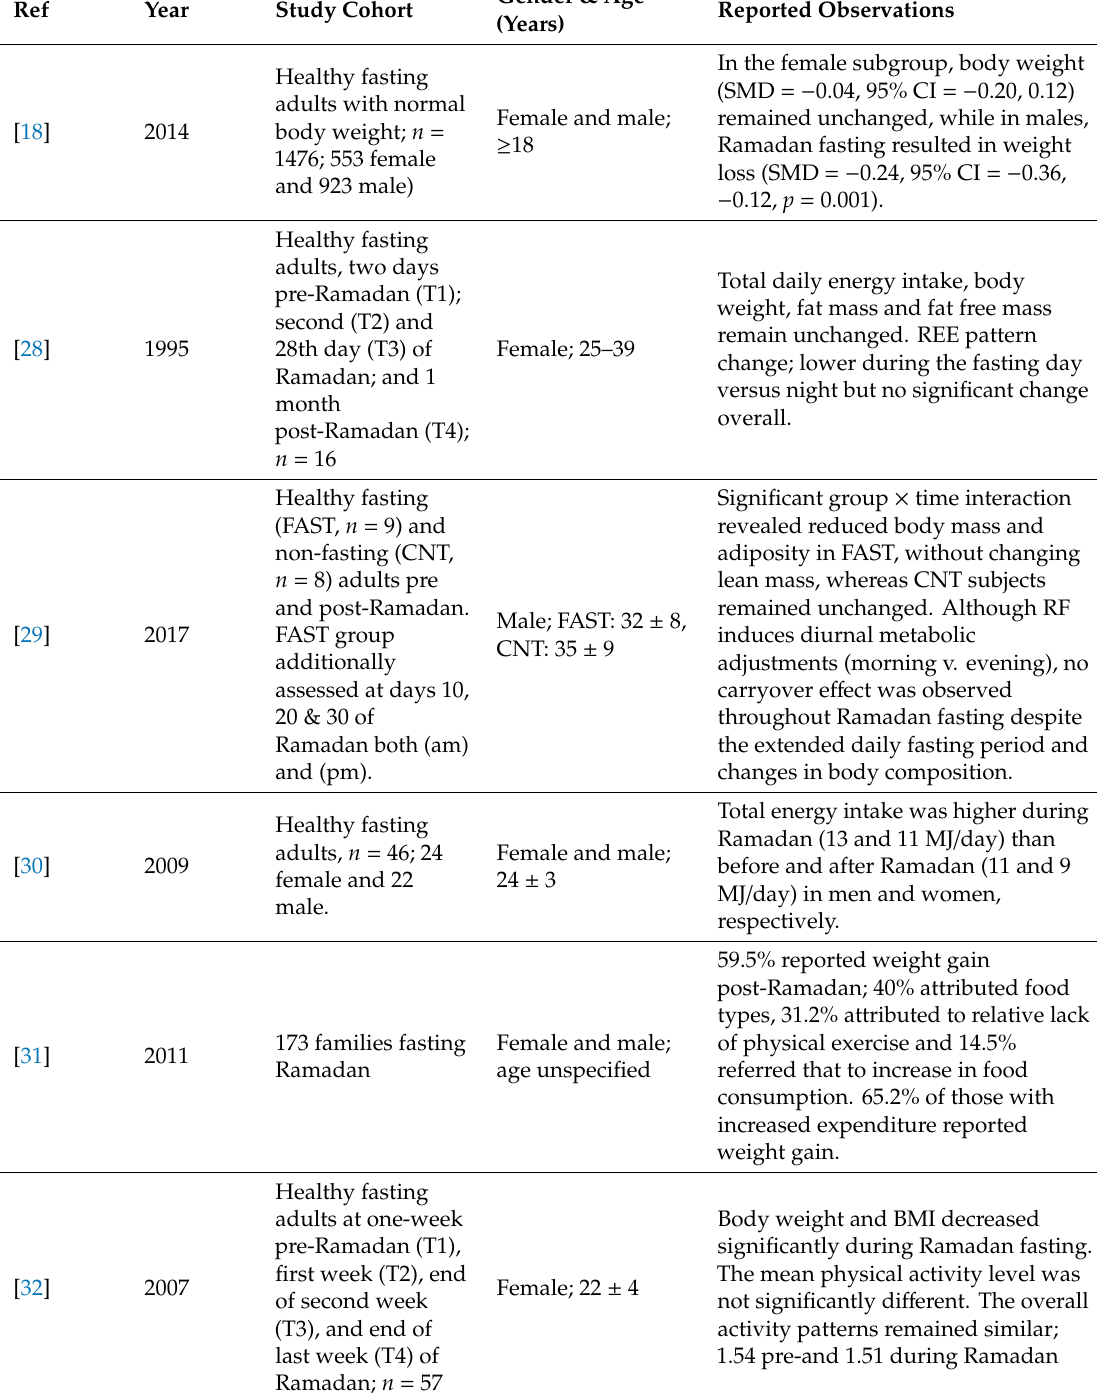
Table 2. Energy intake and weight changes during